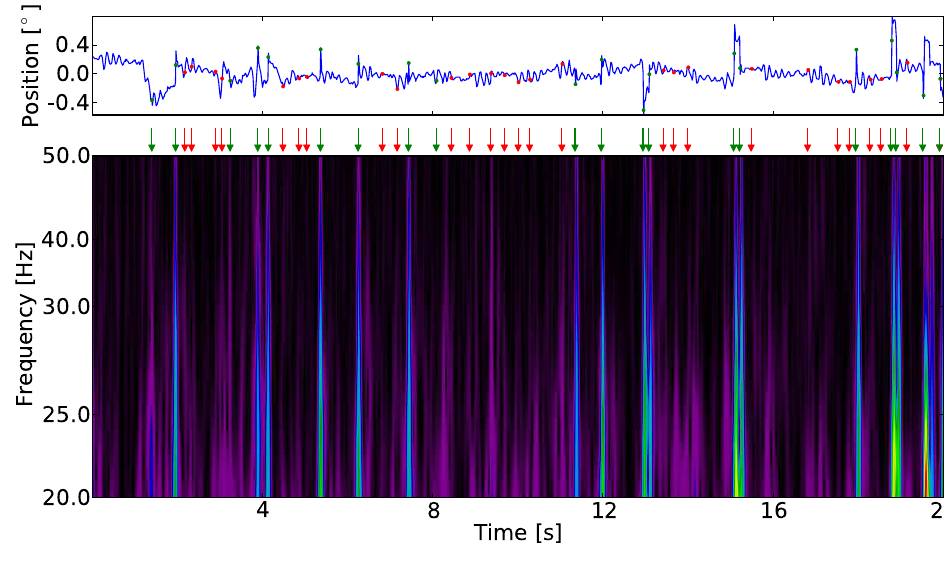
Figure 3 . One horizontal fixational eye movement trajectory in position-time and time-frequency representation. The marker indicate the positions of singularities (red dots and arrows) and binocular (green dots and arrows) singularities. The modulus of the wavelet transform allows the identification of maximum modulus lines. The time point at which a singularity occurs is taken at the highest frequency. The positions of maximum modulus lines match candidates in the time-position trajectory which e.g., by visual inspection would be identified as